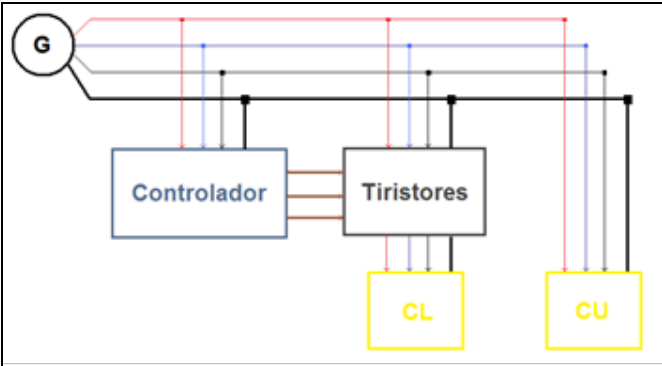
Figura 8: Diagrama de conexiones del Prototipo de pruebas experimentales para control local de la mini-hidroeléctrica. Fuente: [27].